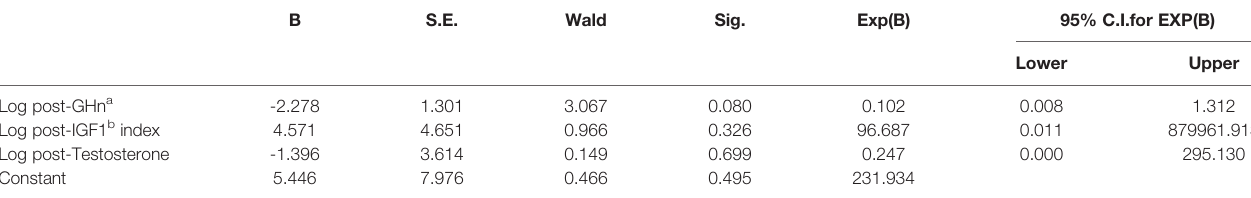
TABLE 6 | Multivariate analysis between patients with and without improvement in erectile function after treatment. B